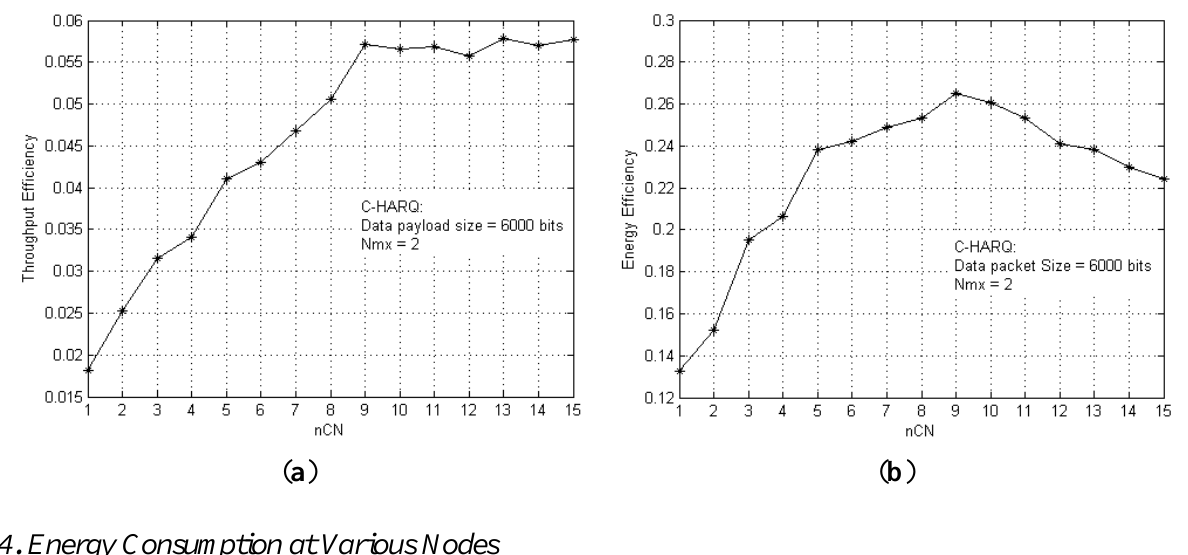
Figure 6. ( a ) Throughput efficiency vs. the number of nodes in the cooperative region ( nCN ); ( b ) Energy efficiency vs. nCN